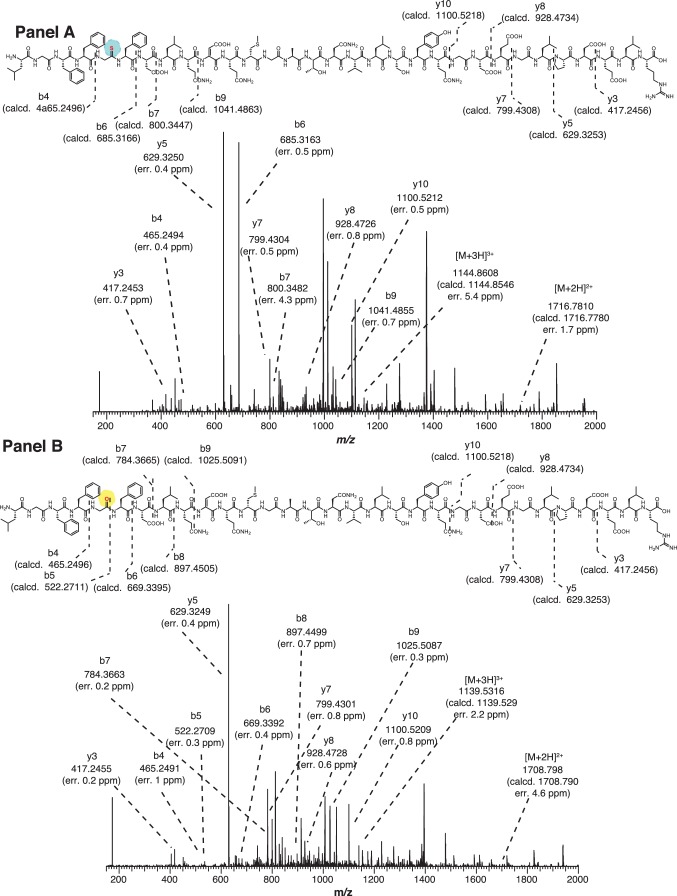
(Panel A) High-resolutions electrospray ionization tandem mass spectrometry (HR-ESI MS/MS) analysis of a wild-type tryptic peptide from Methanosarcina acetivorans McrA (Leu461-Arg491, m/z 3432 Da).The b6 ion localizes the thioamide modification to Gly465. No b5 ion was detected suggesting negligible fragmentation at the thioamide bond. Predicted masses and associated errors are shown. (Panel B) HR-ESI-MS/MS analysis of the corresponding McrA tryptic peptide from the ∆ycaO-tfuA deletion strain of M. acetivorans (m/z 3416 Da). The b5 and b6 ion localizes the amide functionality at Gly465. Predicted masses and associated errors are shown.